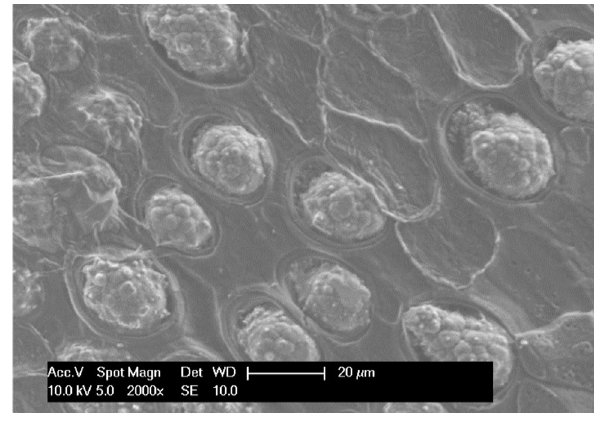
Fig. 2 SEM micrograph of MSC after adsorption of CR